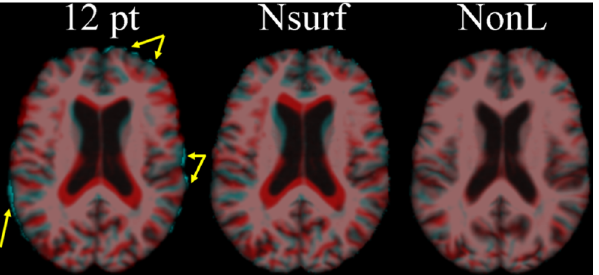
Fig 2. Nonlinear surface (Nsurf — middle panel) normalisation compared to conventional linear (12 pt — left panel) and nonlinear (NonL — right panel) normalisation. Two subjects (one cyan, the other red) were overlaid after each normalisation to the atlas standard space. The yellow arrows highlight differences in head size not accounted for by 12 pt normalisation. Most of the variance between subjects was removed in conventional NonL normalisation (note especially the lateral ventricles in the centre of the